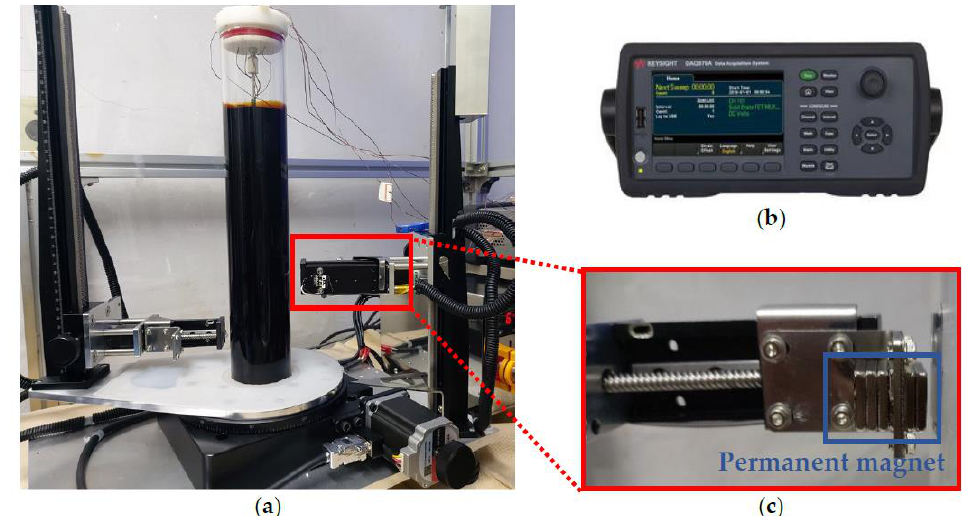
Figure 1. Total experimental device configuration applied in this study ( a ) Total experimental device, ( b ) DAQ (DAQ970A of Keysight), ( c ) Permanent magnet and linear motor.